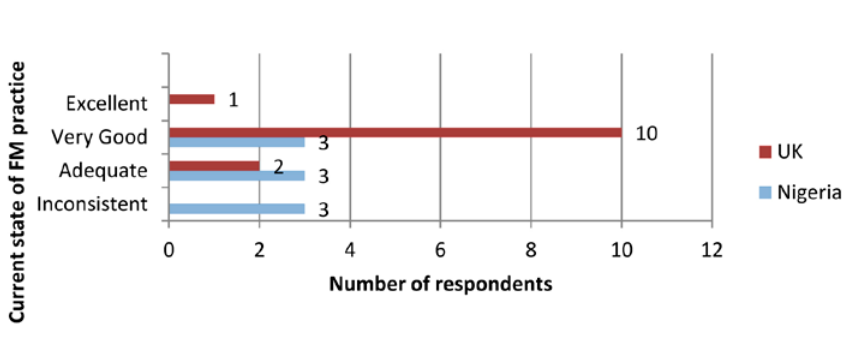
Fig. 2. Comparative analysis of state of FM practice in Nigeria and